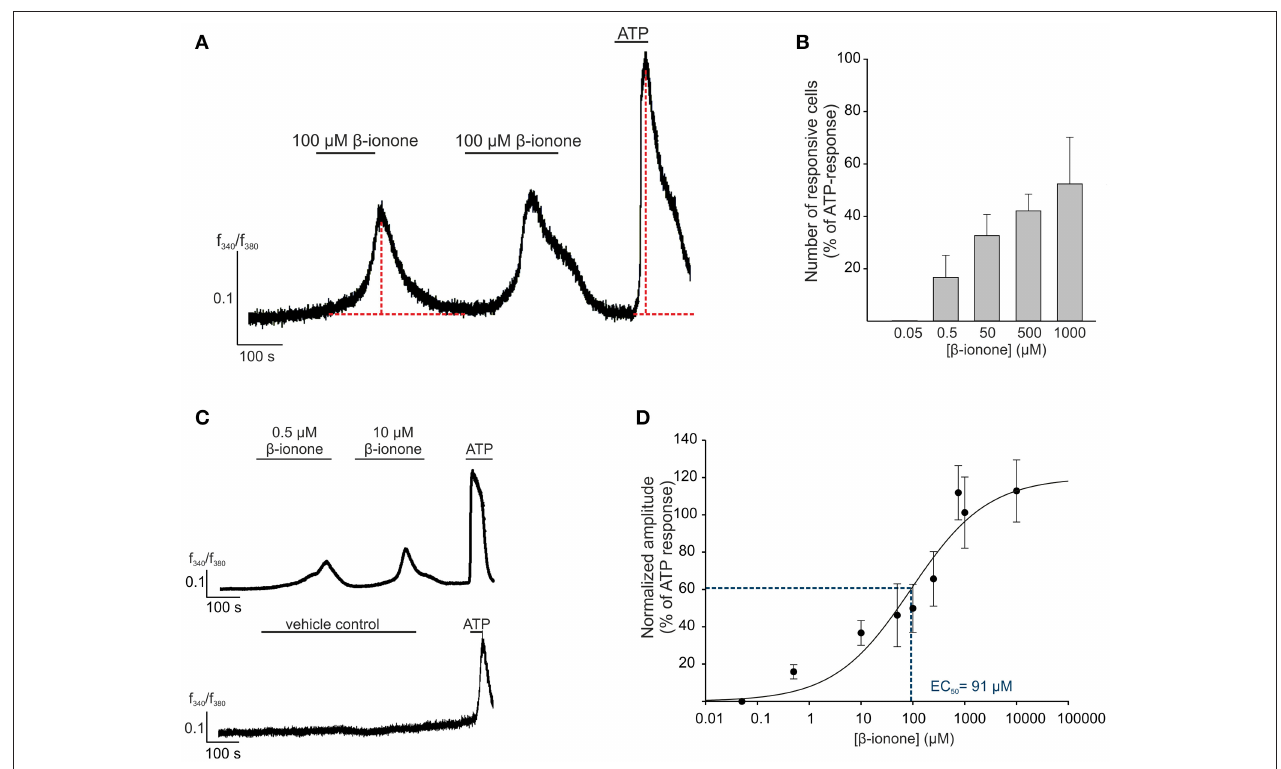
FIGURE 2 | OR51E2-agonist induces Ca 2 + signals in human RPE cells . (A) Representative Ca 2 + imaging trace of a primary RPE cell. Horizontal bars indicate time and duration of stimulus application. β -ionone (100 µ M) application induces a transient rise in intracellular Ca 2 + in the individual cells. ATP (100 µ M) served as the positive stimulus to control cell viability. Cytosolic Ca 2 + levels were monitored as an integrated f 340 /f 380 fluorescence ratio, which is expressed as a function of time. In prolonged stimulation, the maximal signal amplitude was reached after a 3min application of β -ionone. β -ionone induced transient Ca 2 + signals in primary RPE cells upon repetitive stimulation. (B) The β -ionone-induced Ca 2 + increase is dose-dependent. β -ionone was applied at different concentrations to ensure the maximal number of responsive cells. The number of responsive cells was normalized to the number of ATP-responsive cells [positive control ( n = 5–7)]. (C) Representative Ca 2 + imaging trace of a Fura-2-loaded human RPE cells. Application of β -ionone induces intracellular Ca 2 + increase in a dose-dependent manner (upper panel). Application of the solvent (0.1% DMSO) did not result in any changes in cytosolic Ca 2 + level (lower panel). (D) Dose-response curve of the β -ionone-induced Ca 2 + signals. The signal amplitude, at the first application, was normalized to the amplitude evoked by ATP and is displayed as a function of the applied β -ionone concentration. The EC 50 value was 91 µ M. ( n =